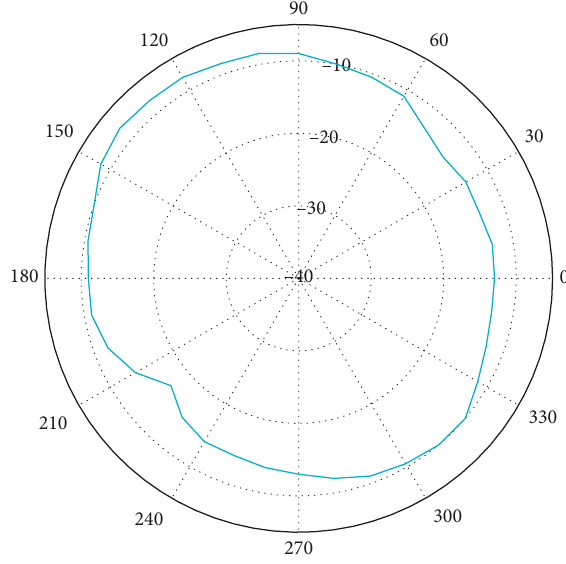
Figure 13: Emission diagram in horizontal polarization in the 2 nd plane (dbm).